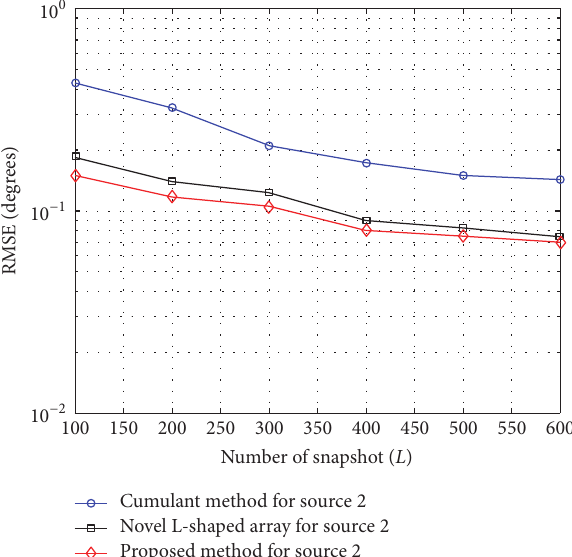
Figure 8: RMSE of azimuth-elevation versus number of snapshots at SNR = 10dB for source 2 located at (65 ∘ ,80 ∘ ) using proposed method, novel L-shaped, and cumulant method.